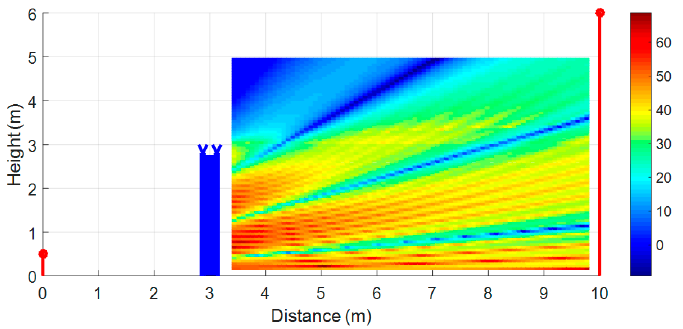
Figure 22. IL map at 1500 Hz in the ‘car’ location. Barrier with the ‘Y–Y’ cap and 3 m height.